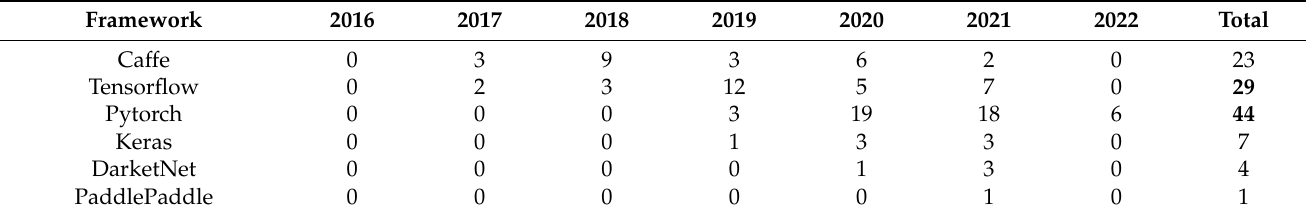
Table 4. The deep learning framework those papers